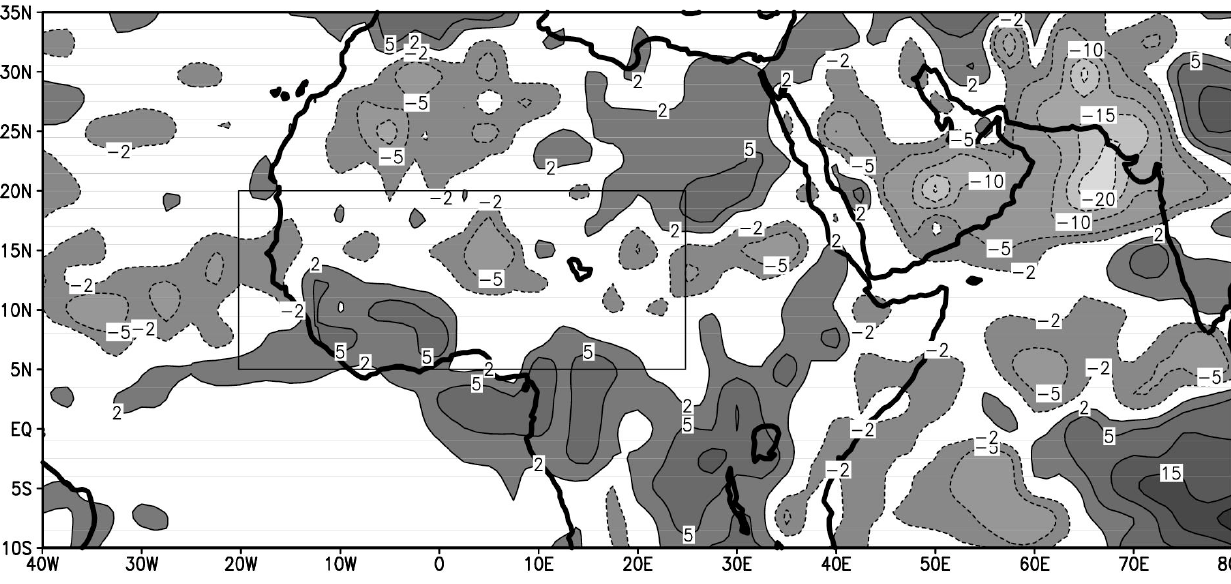
Figure 2. July-September 2006 OLR anomalies relative to 1990-2005. Negative (positive) values in the ITCZ area means enhanced (weakened) convection. The box locates the domain of Fig.1a.